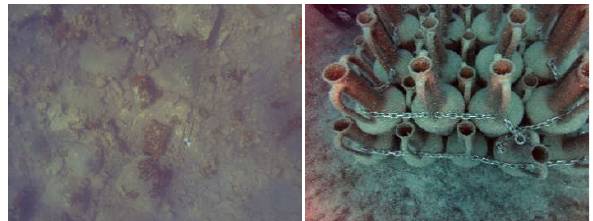
Figure 4. . Corrected (a) imagery with Adobe Photoshop ® for shallow and deep (b) water